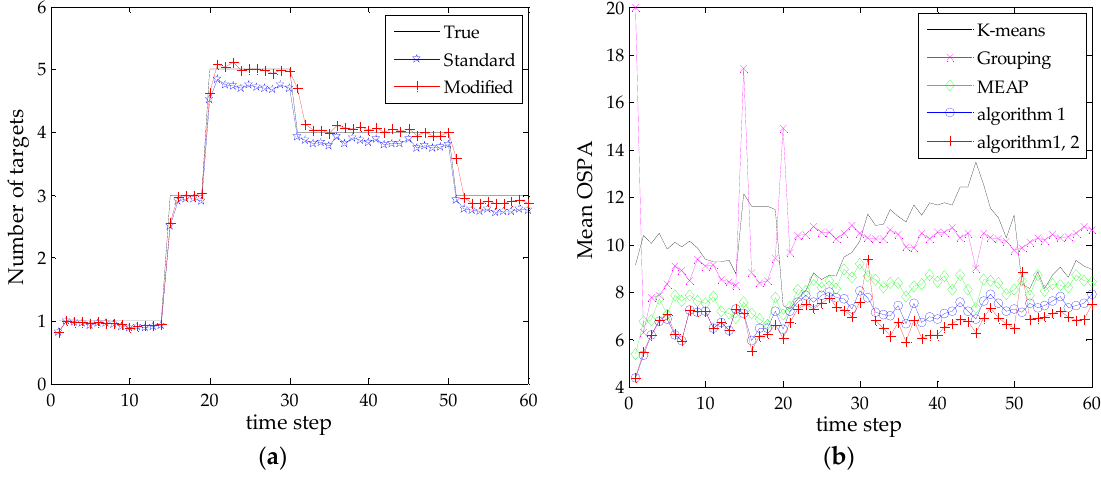
Figure 4. Target number estimate and mean OSPA distance versus time ( r “ 10): ( a ) Target number estimate versus time; ( b ) Mean OSPA distance versus time.